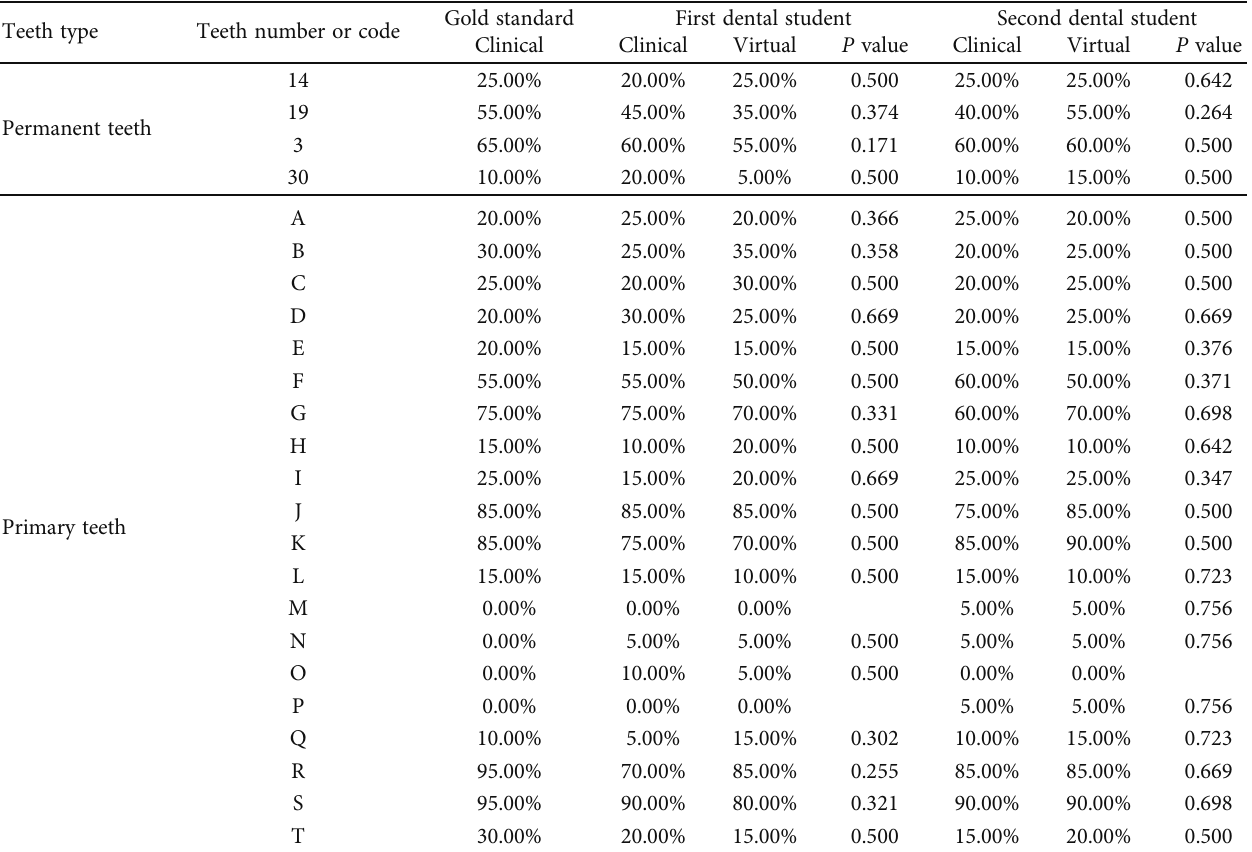
Table 2: Comparison of the frequency of carious teeth detected clinically and virtually by the two dental students and the gold standard for 24 types of teeth.